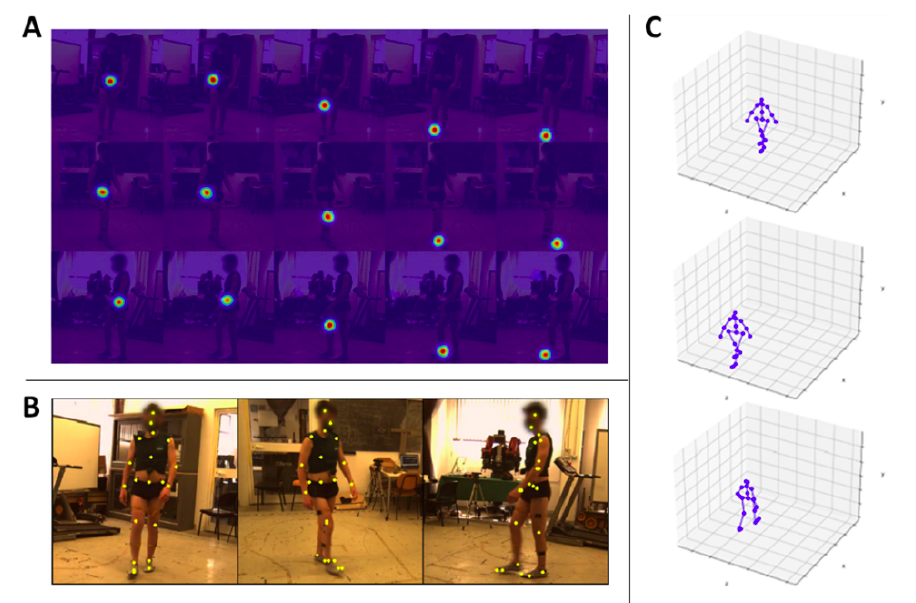
Figure 4. ( A ) Examples of the detected probability maps ( U j , i , l ) for the j -th participant at a specific t time instant t . The rows represent the 3 different viewpoints i . Each column represents a different keypoint l detected on the right leg (from left to right: hip, knee, heel, toe). ( B ) Examples of the detected keypoints (yellow dots) on the three views composing our dataset. ( C ) Examples of the final 3D skeleton of the video